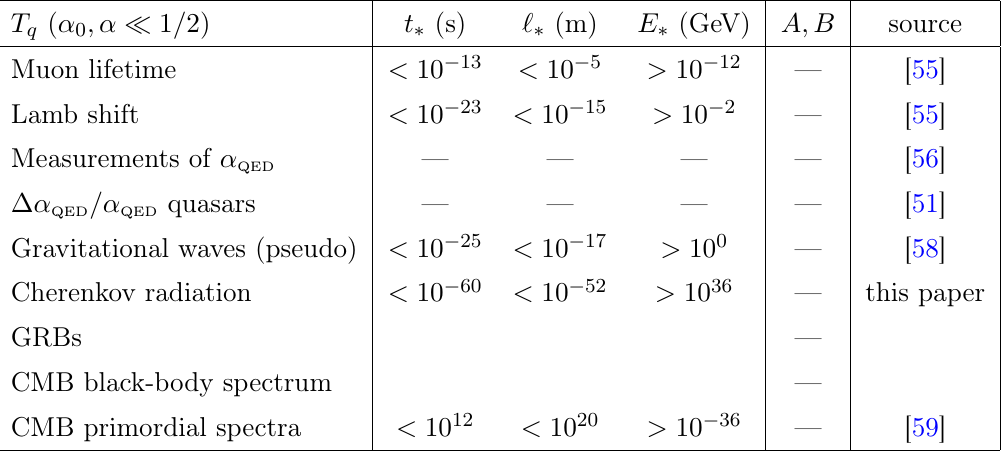
Table 6 . Absolute bounds on the hierarchy of multifractional spacetimes with q -derivatives (ob- tained for (cid:11) 0 ; (cid:11) (cid:28) 1 in all cases but for the last one, where a likelihood analysis has been used). “Pseudo” indicates bounds obtainable in the stochastic view, where T q is regarded as an approxi- mation of T (cid:13) = (cid:11)